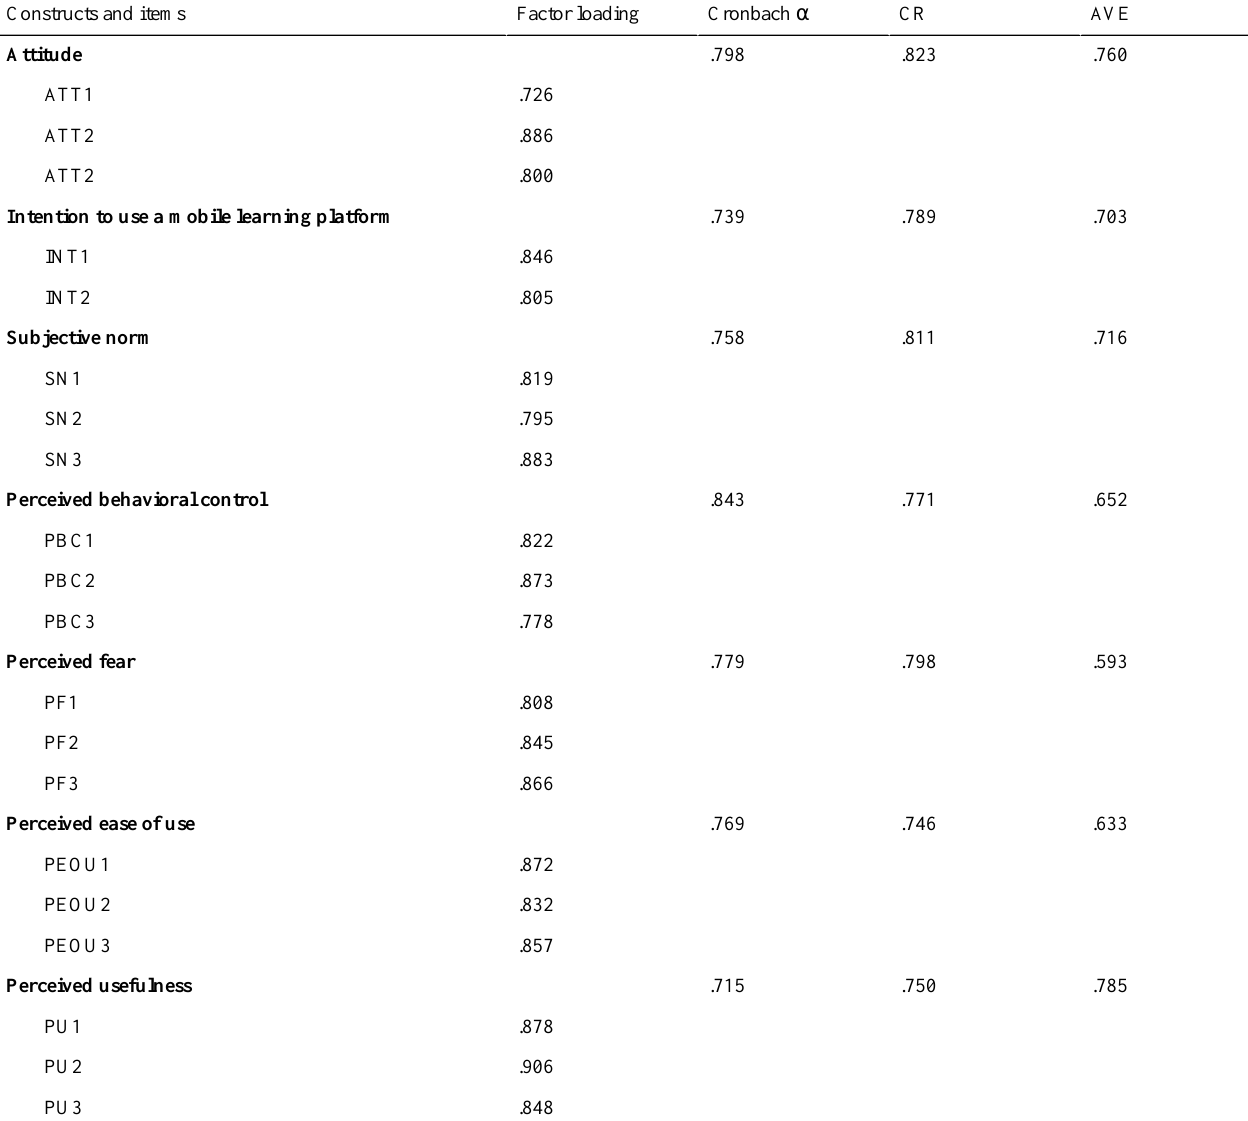
Table 5. Convergent validity test results. Acceptable values (ie, factor loading, Cronbach α , CR a ≥ 0.70, and AVE b >0.5) were obtained.